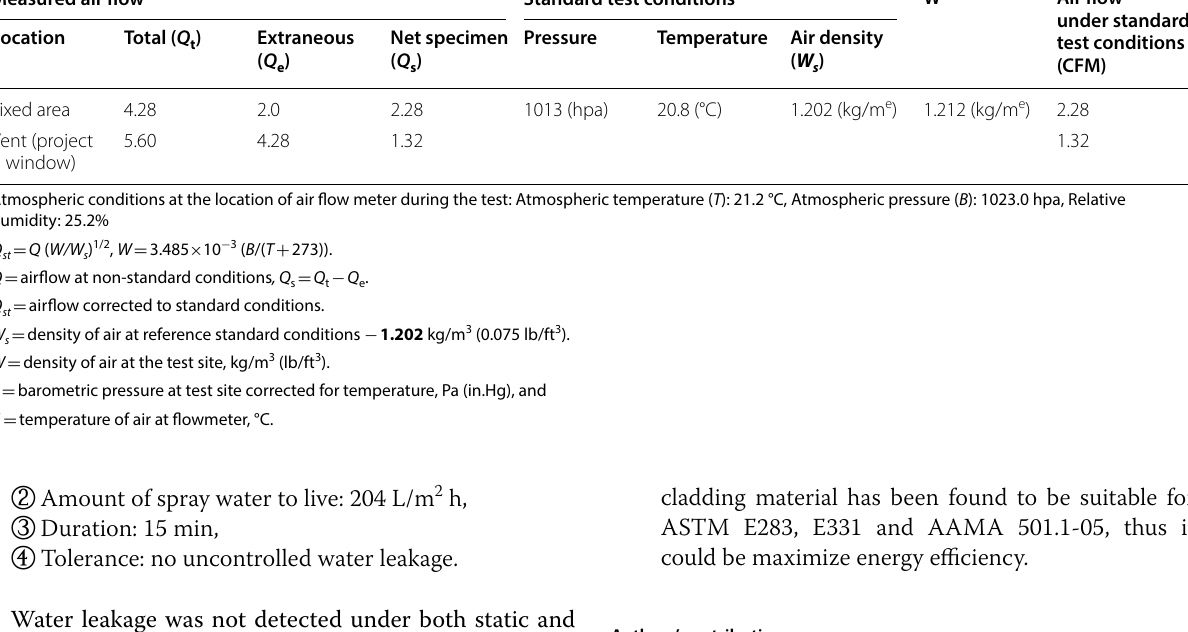
Table 10 Conversion of air flow rate during air tightness test.